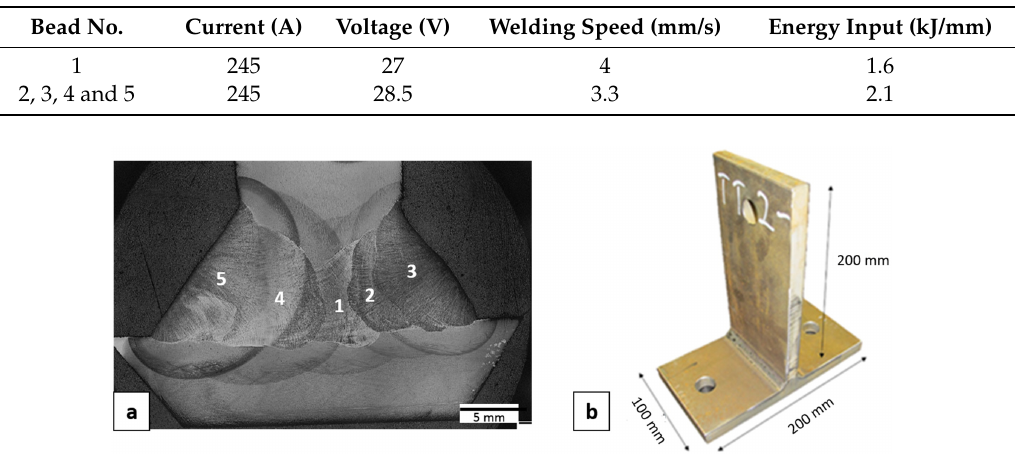
Figure 1. ( a ) The welding sequence with five beads; ( b ) Design and dimension of T-shaped sample used in residual stress measurements.